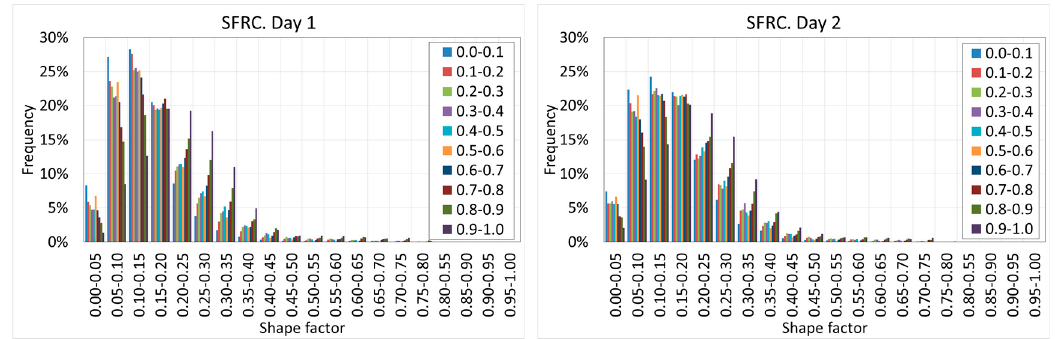
Figure 21. Histogram of the shape factor of PC.